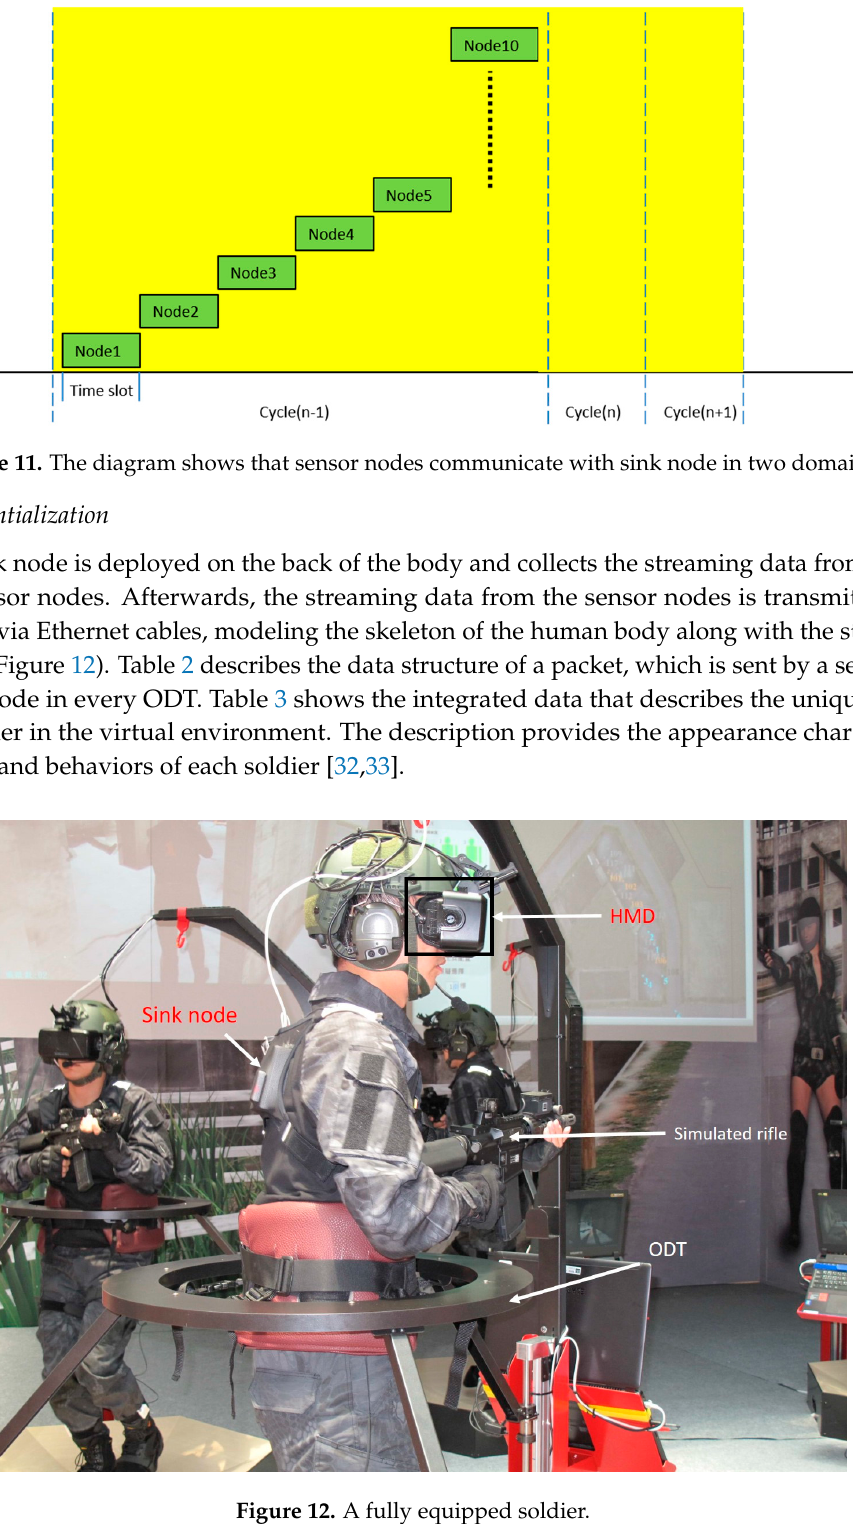
Table 2. Data structure of a packet.